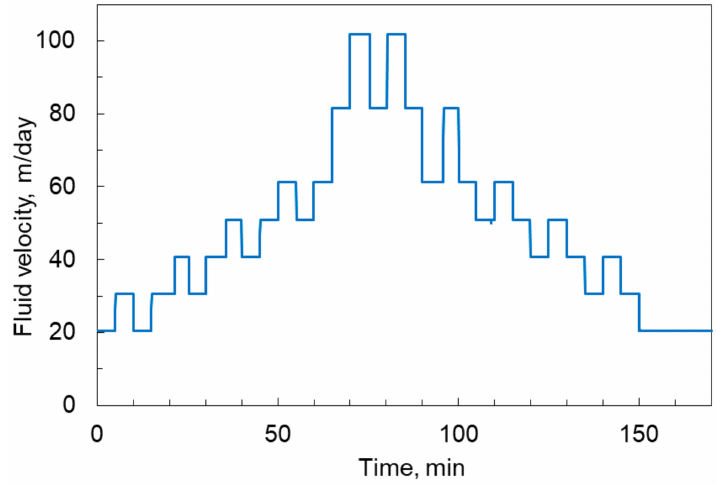
Figure 2. Fluid injection